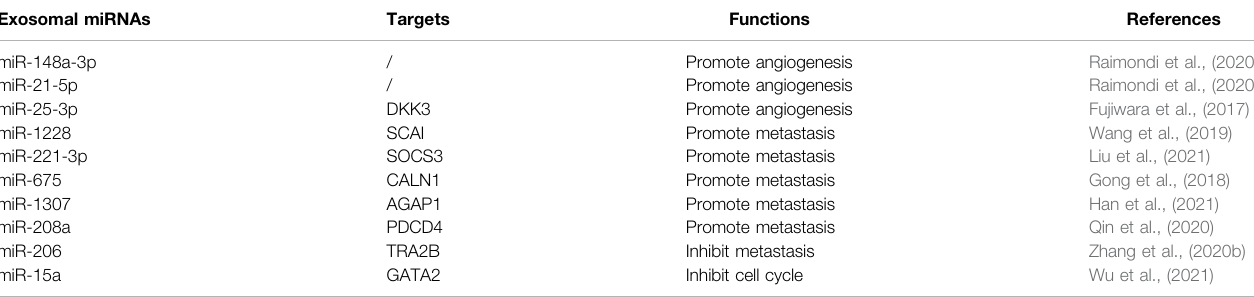
TABLE 1 | Exosomal miRNAs involved in osteosarcoma